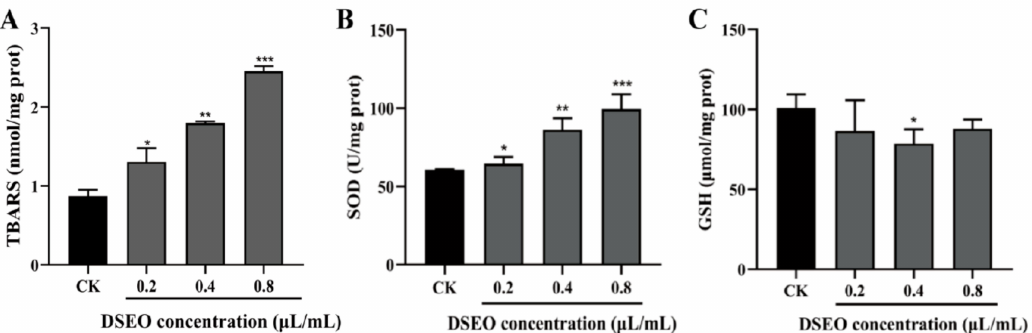
Figure 4. The effects of DSEO on oxidative stress indicators of N. parvum , ( A ) MDA levels, ( B ) SOD levels, and ( C ) GSH levels. “CK” represents “control”. Statistical significance was set at * p < 0.05, ** p < 0.01, *** p <